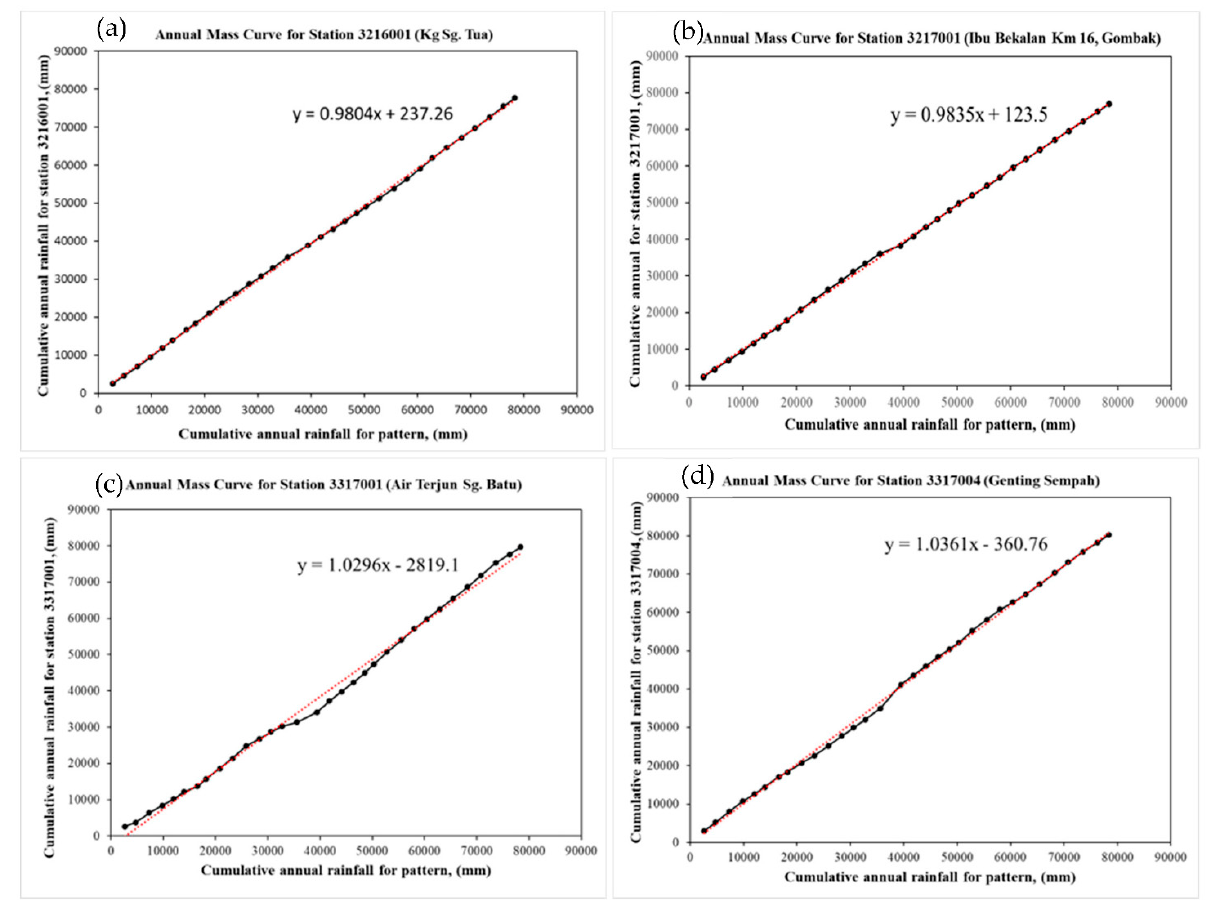
Figure 9. Double mass curve of the station ( a ) Kg Sg Tua (3216001), ( b ) Ibu Bekalan KM16 (3217001), ( c ) Air Terjun Sg Batu (3317001), and ( d ) Genting Sempah (3317004).